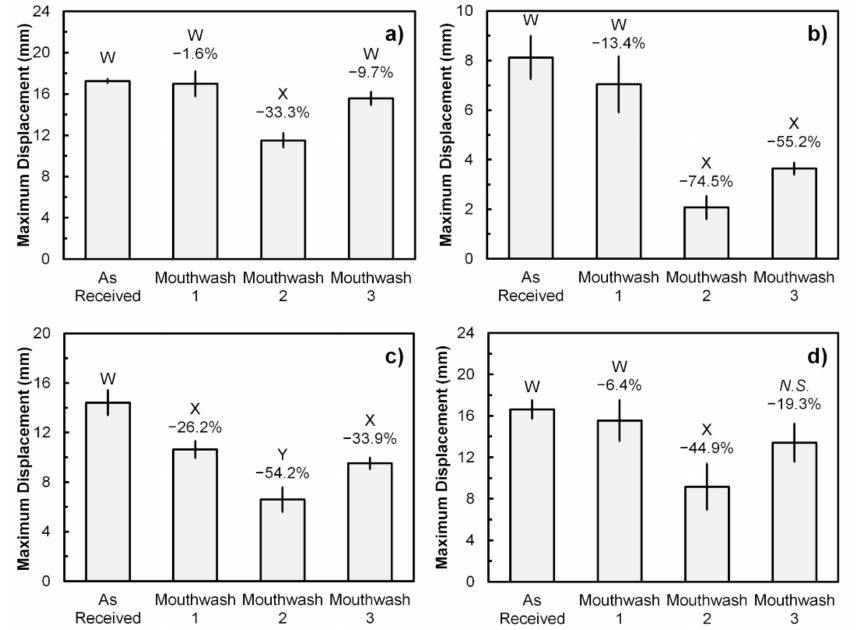
Figure 4. The maximum displacement obtained from universal tensile testing of the as-received and mouthwash-rinsed samples: ( a ) Brand A; ( b ) Brand B; ( c ) Brand C; and ( d ) Brand D. Error bars represent SD ( n = 3). Different W, X, and Y letters between the sample groups represent p < 0.05 (One-way ANOVA with Tukey’s HSD pairwise comparison) when compared against each other. N.S. represents p > 0.05 when compared with either W or X. Reduction percentages are relative to the As-Received